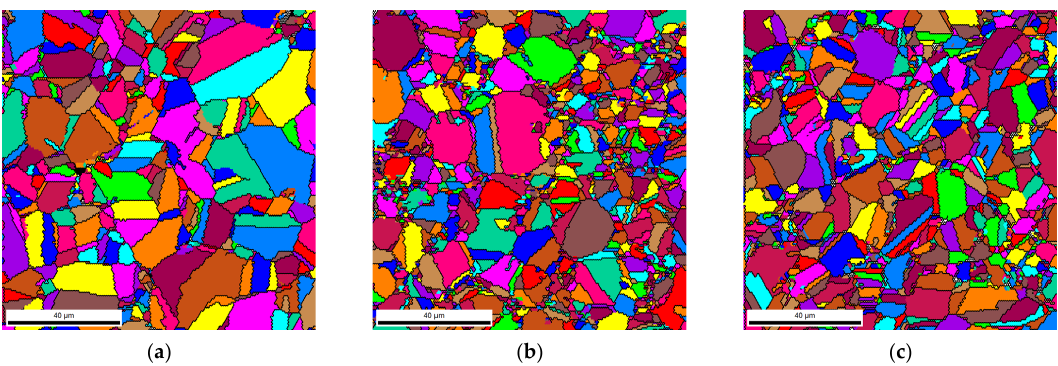
Figure 3. Unique grain color maps of heat-treated samples at 1100 °C for 30 min of ( a ) Ni, ( b ) Ni-0.50 vol.% CNT, and ( c ) Ni-1.00 vol.% CNT.